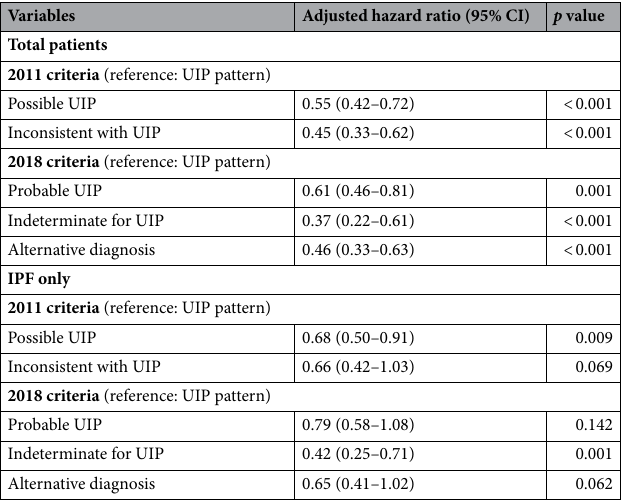
Table 4. Cox proportional hazard analysis for survival time. Hazard ratios were adjusted by age, sex, baseline (% predicted) forced vital capacity (FVC), diffusing capacity of the lung for carbon monoxide (DL CO ) and use of anti-fibrotics. CI confidence interval; UIP usual interstitial pneumonia; IPF idiopathic pulmonary fibrosis; iNSIP idiopathic nonspecific interstitial pneumonia; cHP chronic hypersensitivity